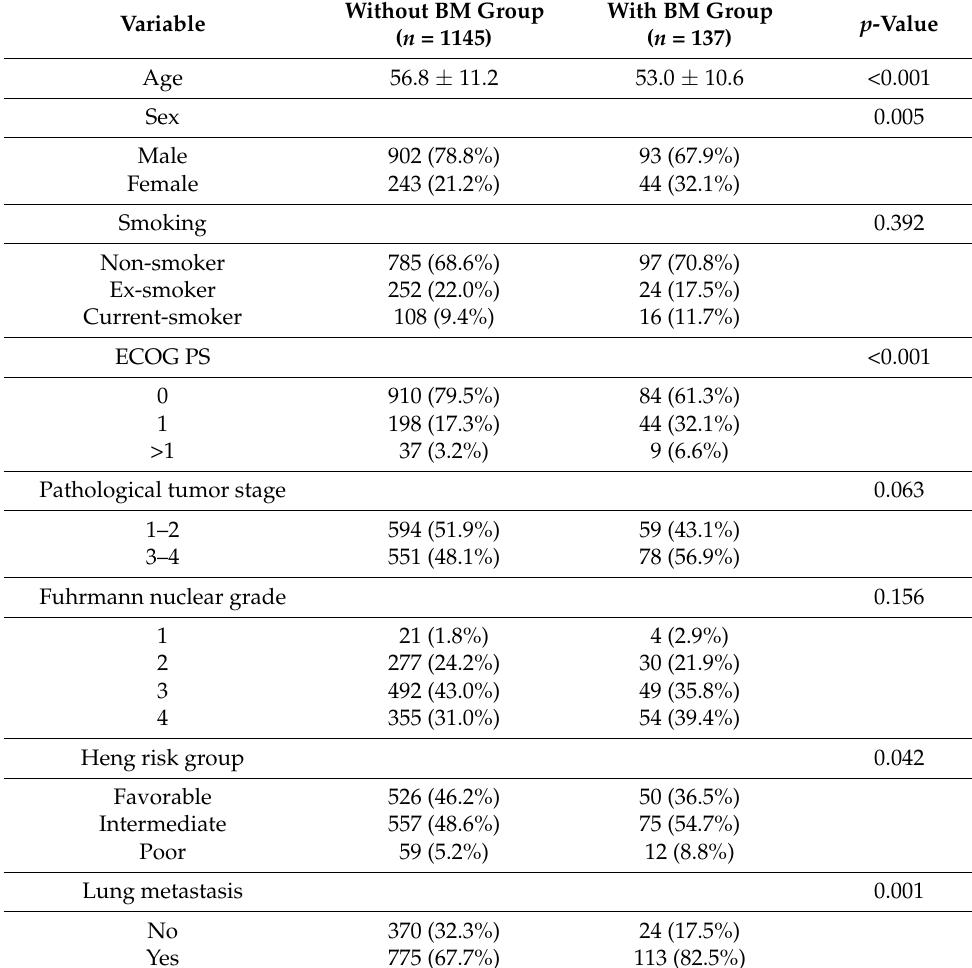
Table 1. Comparison of characteristics between groups with and without brain metastasis